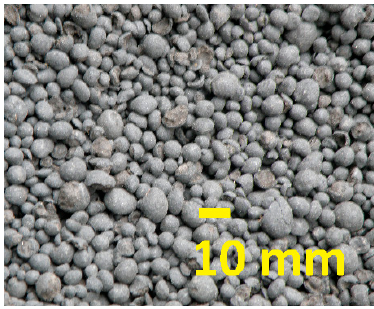
Figure 1. Granulated sewage sludge.